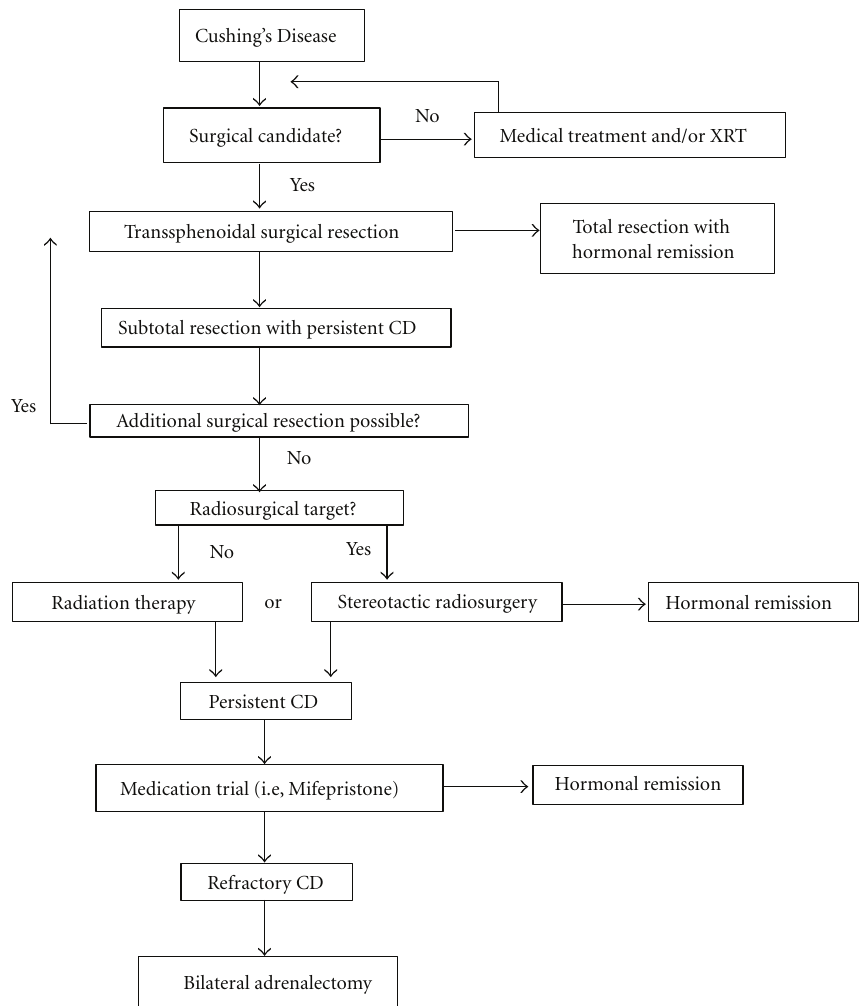
Figure 2: A stepwise algorithm for the multimodality treatment options available in Cushing’s Disease. (Abbreviations: XRT: radiation therapy, CD: Cushing’s